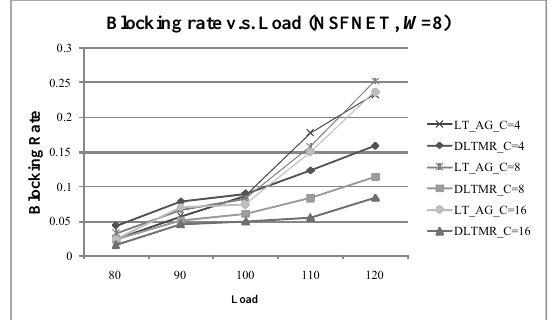
Fig. 11. The effect of traffic granularity on blocking rate (NSFNET)